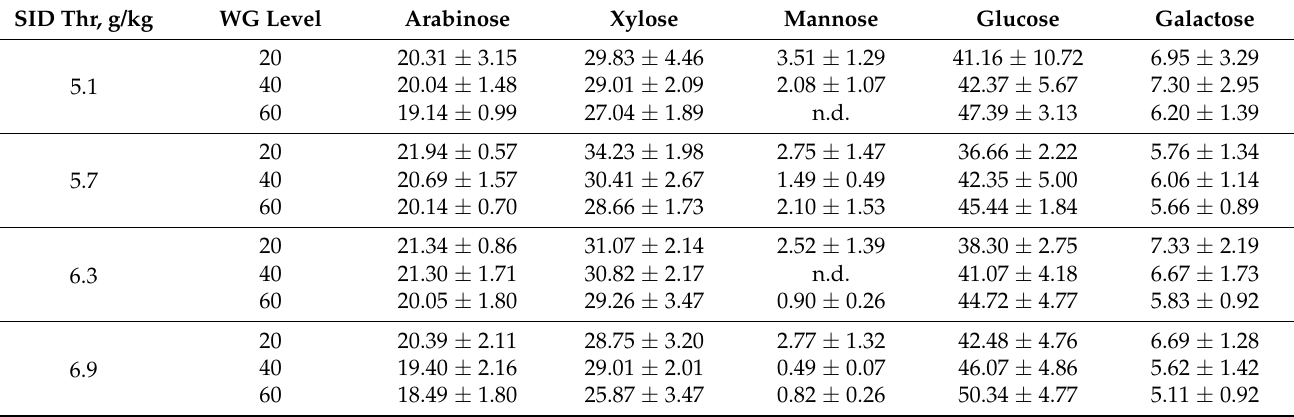
Table 3. Sugar composition (mol/100 mol) in ileal digesta of pigs fed diets differing in standardized ileal digestible threonine (SID Thr) content and wheat gluten (WG)